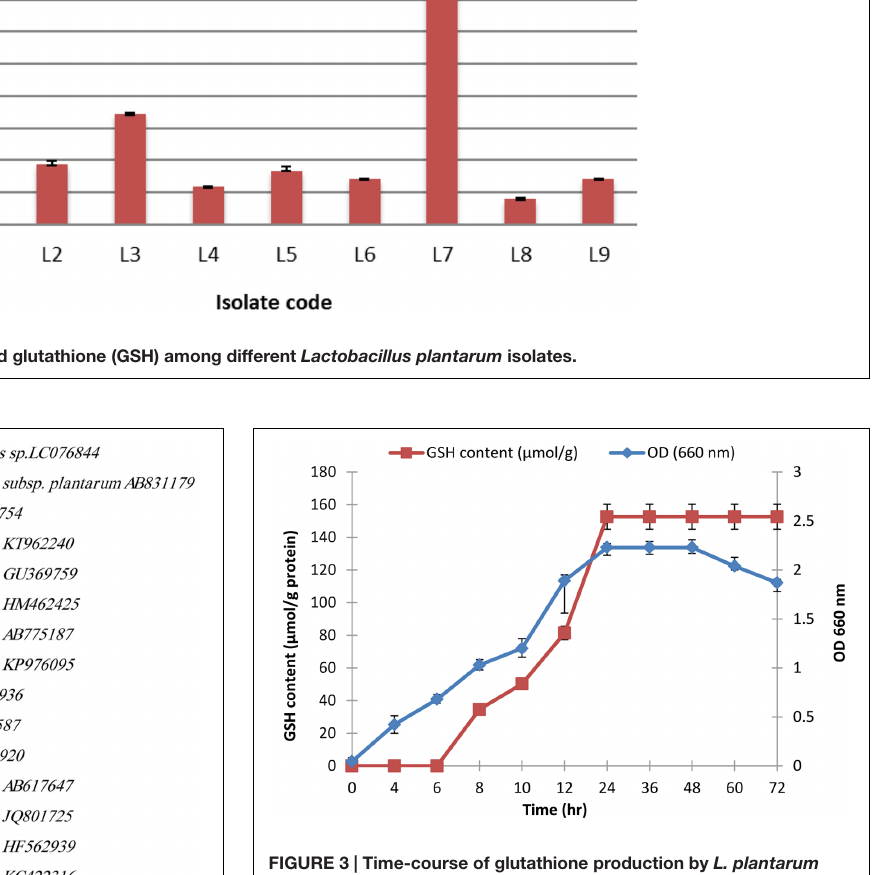
FIGURE 3 | Time-course of glutathione production by L. plantarum along with the biomass.